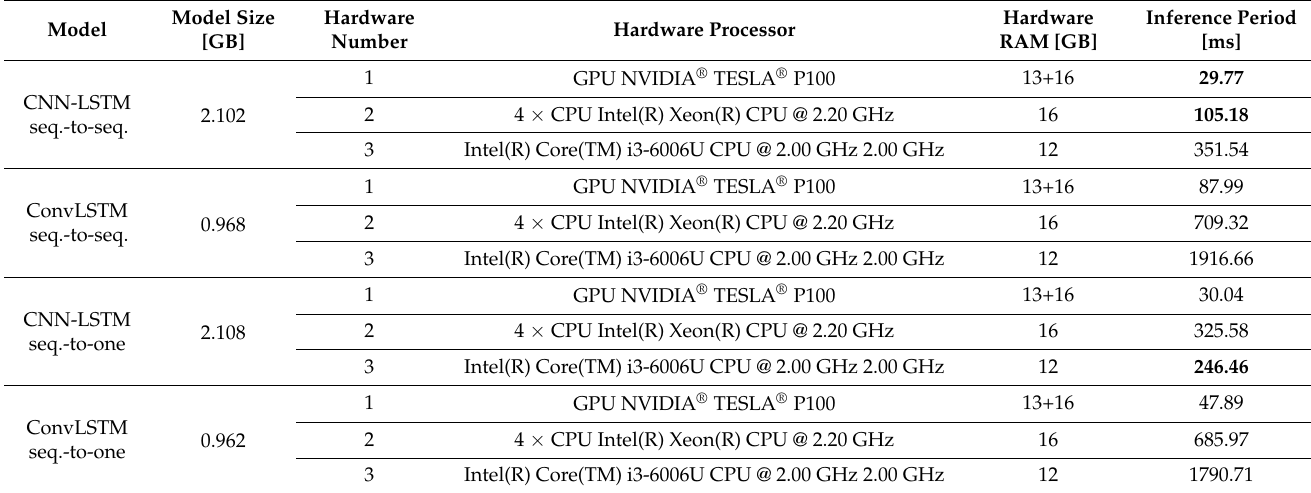
Table 2. Inference speed of one prediction for all developed models on different